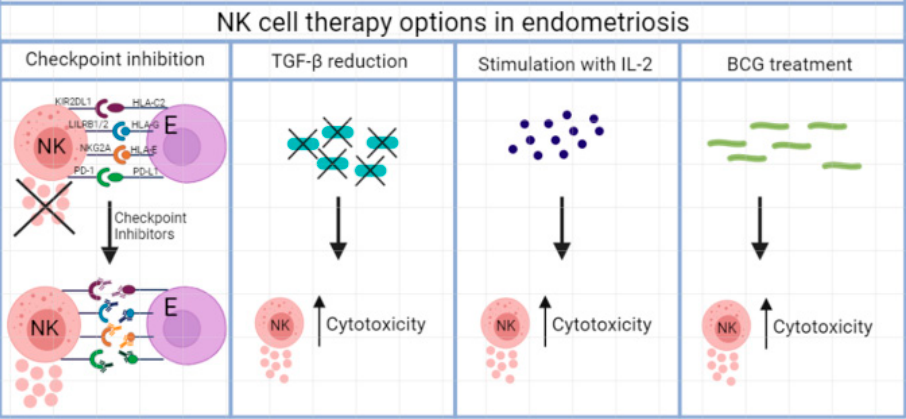
Figure 2. Different NK cell therapy options in endometriosis, whereby cytokine release is improved and NK cell cytotoxicity increased.